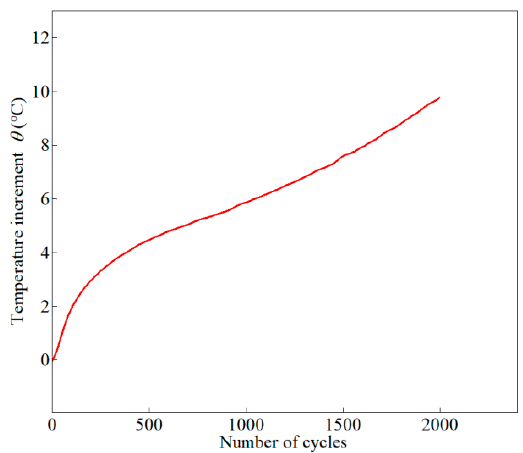
Figure 10. The thermal evolution in 2000 cycles under stress amplitude 340 MPa.